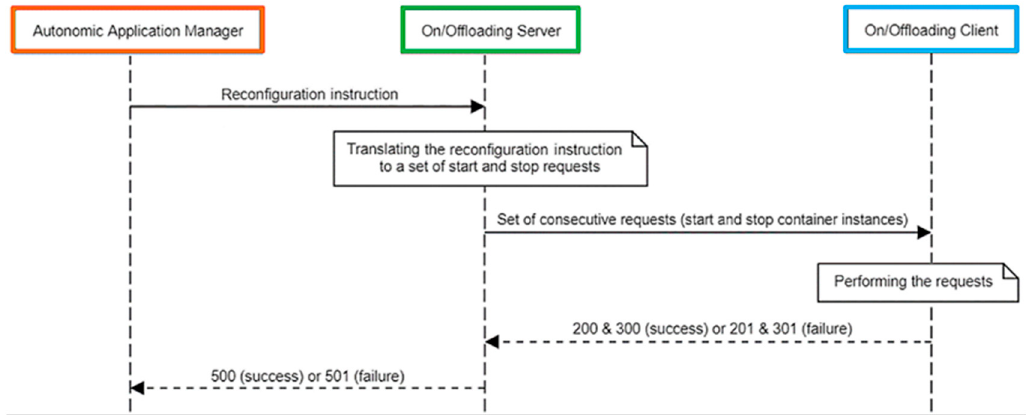
Figure 4. Sequence diagram for an on/offloading scenario performed by the capillary computing architecture.